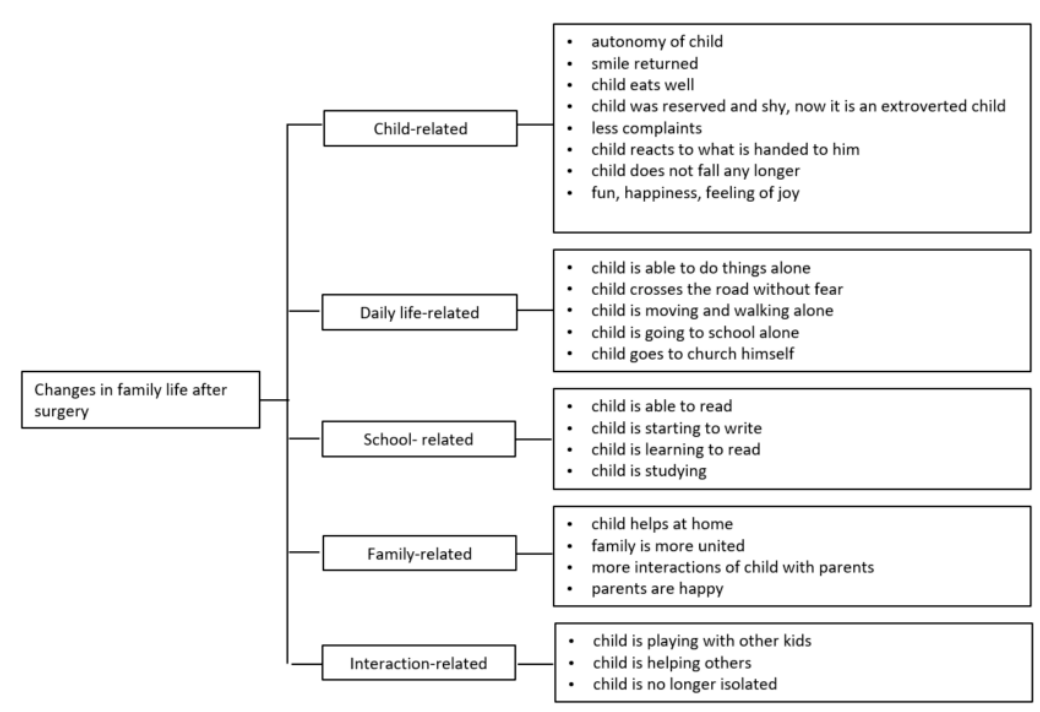
Figure 5. Changes in family life after surgery.